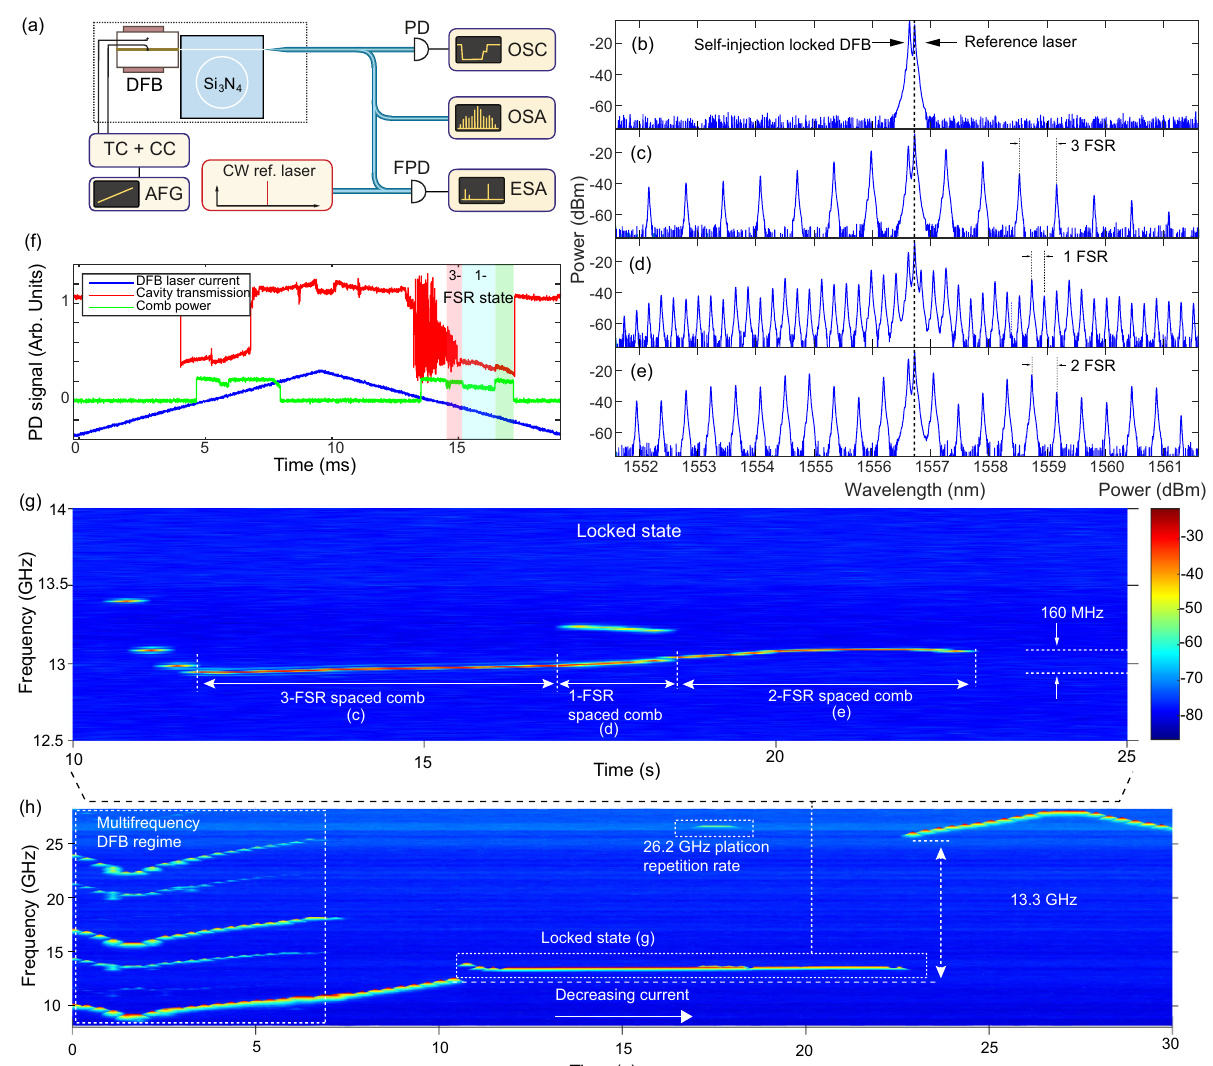
Fig. 3 Characterization of dynamics of self-injection-locked platicon microcombs. a Experimental setup. TC + CC: temperature and current controllers for the DFB laser. AFG: arbitrary function generator. PD, FPD: photodiode. OSC: oscilloscope. OSA: optical spectrum analyzer. ESA: electrical spectrum analyzer. b – e Optical spectra of different comb states upon backward tuning (decreasing laser current). The reference laser peak is at 1556.72 nm. f Microresonator transmission trace (red) and generated comb light (yellow) upon forward (increasing laser current) and backward scan of the DFB laser current (blue). Shaded red, blue and green areas correspond to the formation of 3-, 1-, 2- FSR spaced combs, which are delineated by the abrupt rise or fall of the comb power detected by the photodetector. h Beatnote spectroscopy of laser self-injection locking upon decreasing the DFB current, to reveal the laser dynamics. g Zoom in of ( h ) from 10 s to 25 s. The signal at 12.93 GHz corresponds to a heterodyne beat of locked laser and a reference laser. The beatnote between the fi rst comb line and a reference laser is 13.23 GHz. The locking range is 13.3 GHz (from 12.07 to 25.37